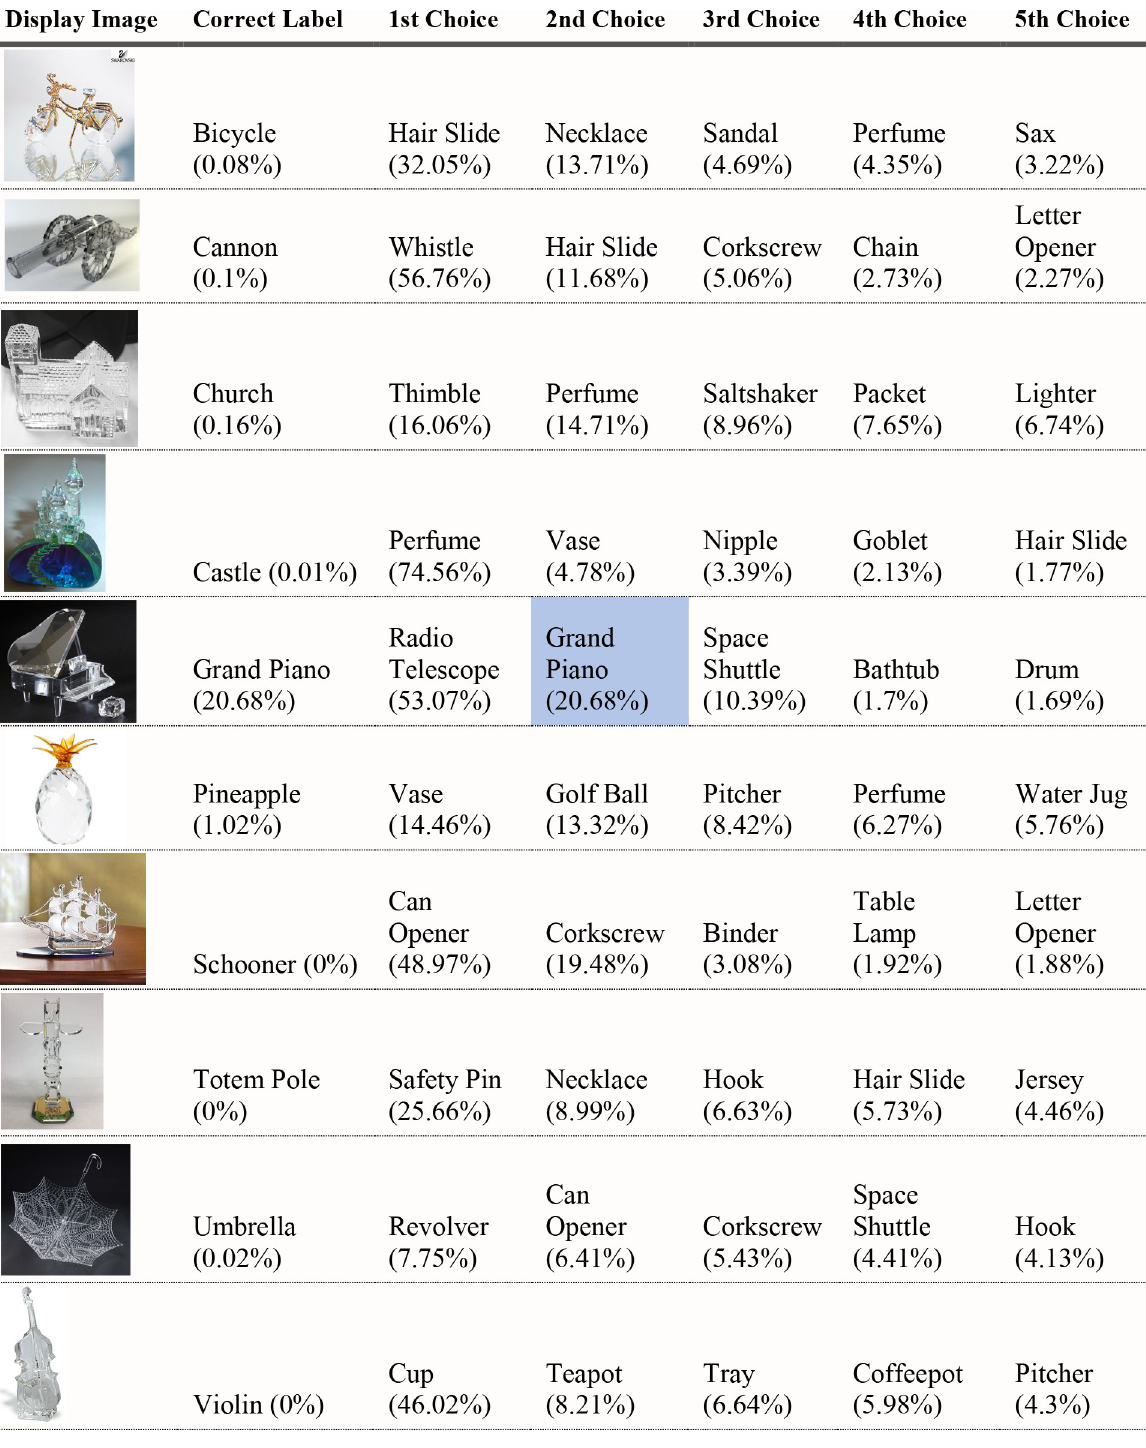
PLOS Computational Biology | https://doi.org/10.1371/journal.pcbi.1006613 December 7,